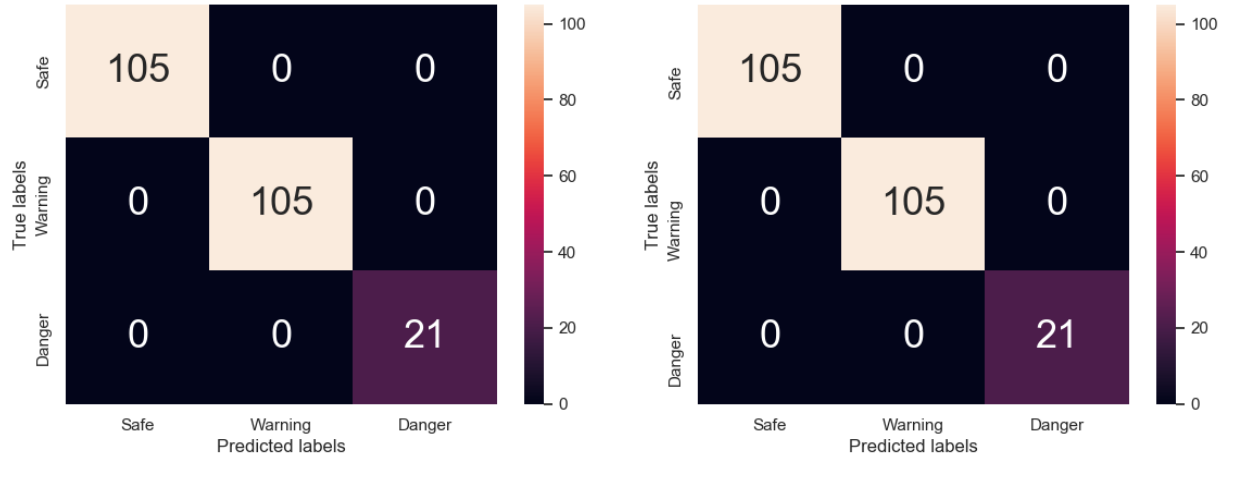
Figure 9. Confusion matrices for ( a ) Transformer and ( b ) CNN models, trained on steel and silicone impactor data